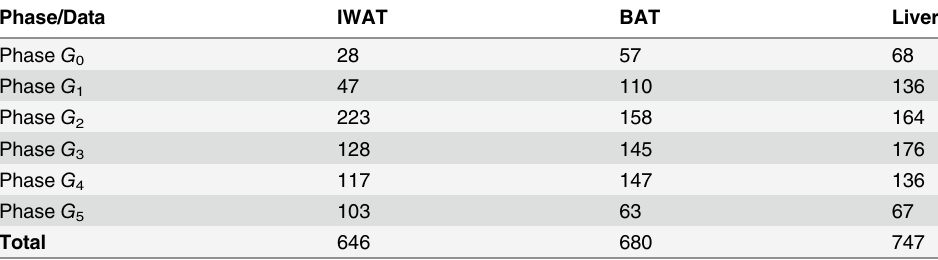
Table 1. Number of genes in each phase for the IWAT, BAT and Liver data sets. Phase/Data IWAT BAT